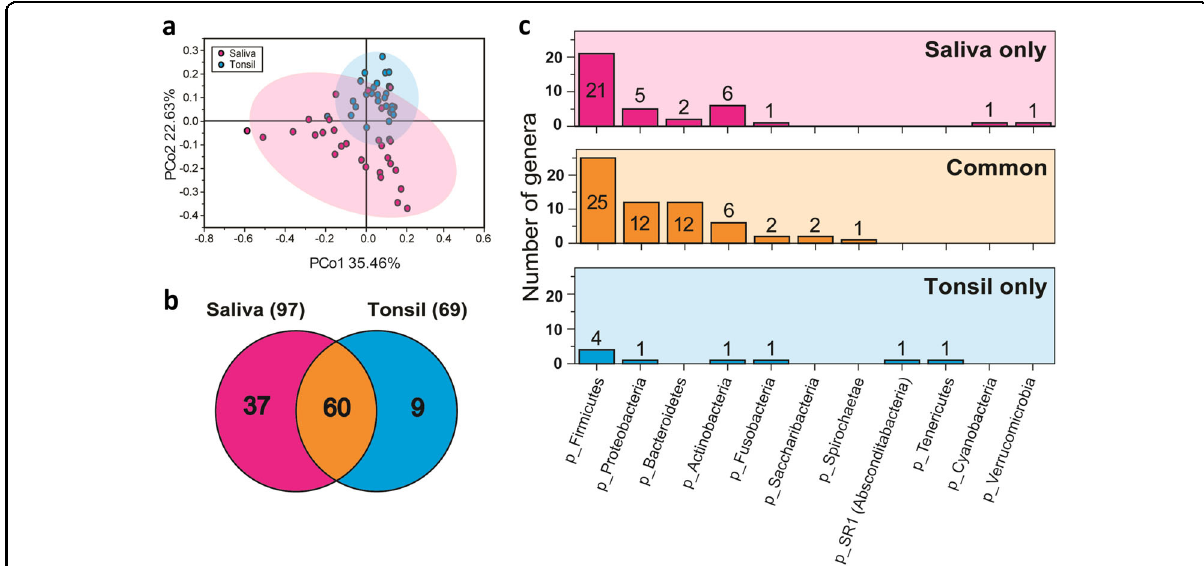
Fig. 3 Comparison of saliva and tonsil groups at the genus level. Principal coordinate analysis plots of Bray-Curtis-computed distances between saliva and tonsils. a Saliva (red) and tonsil (blue) samples are colored according to the subject. The plot presents a 95% con fi dence ellipse with a color background. b Venn diagram showing the overall overlap between saliva and tonsils at the genus level. c Number of speci fi c and common genera between saliva and tonsil samples at the phylum